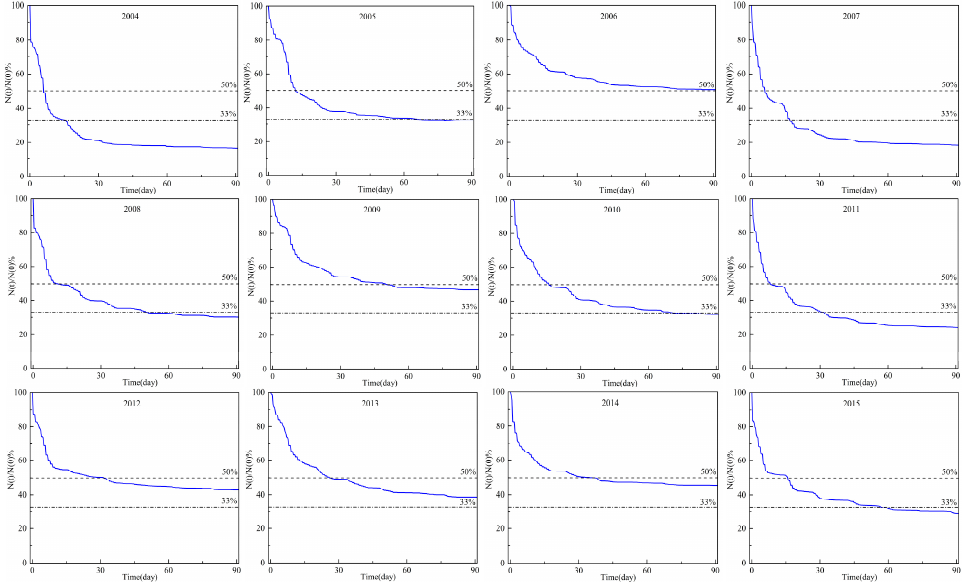
Figure 8. The number of particles remaining in the bay relative to the initial numbers in summer (2004 – 2015).